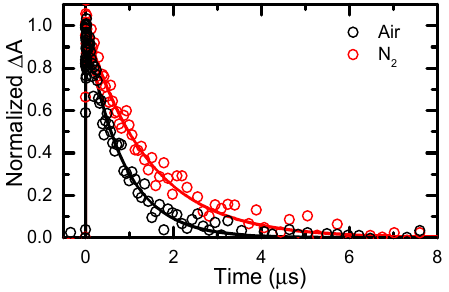
Figure 6. Representative decay-traces for 6tGua triplet absorption monitored at 350 nm in PBS under air- and N 2 -saturated conditions following 345 nm excitation. Traces were fitted to a single-lifetime exponential kinetic model.